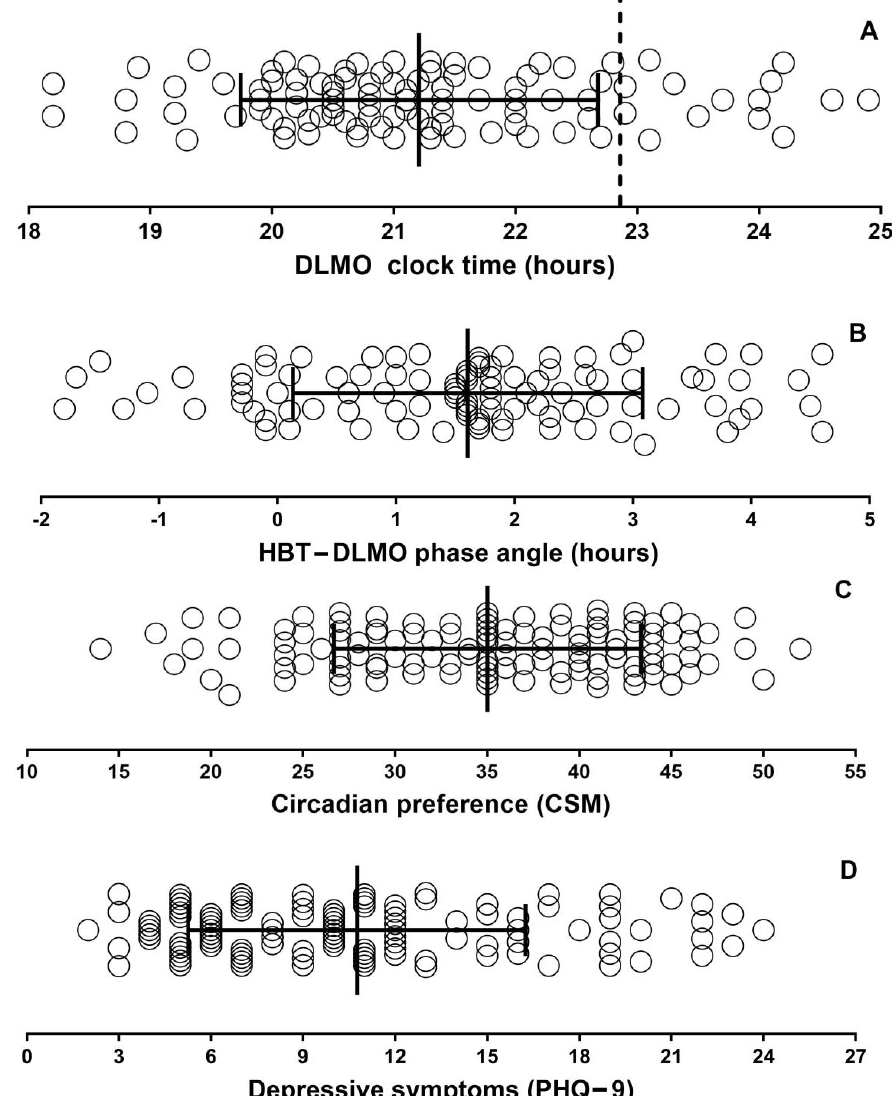
Figure 1. Dim light melatonin onset clock time ( A ), phase angle ( B ), circadian preference (Composite Score of Morningness) ( C ), and depressive symptoms ( D ) for all participants. Vertical dashed line in A shows average habitual bedtime (diary). Solid lines represent mean and SD. Key: DLMO — dim light melatonin onset; HBT — habitual bedtime sleep; CSM — Composite Scale of Morningness; PHQ-9 — Patient Health Questionnaire. Table 1. Demographic, sleep and clinical measures of the participants. Key: ISI — Insomnia severity index; PSQI — Pittsburgh sleep quality index; CSM — Composite Scale of Morningness; DBAS — Dys-